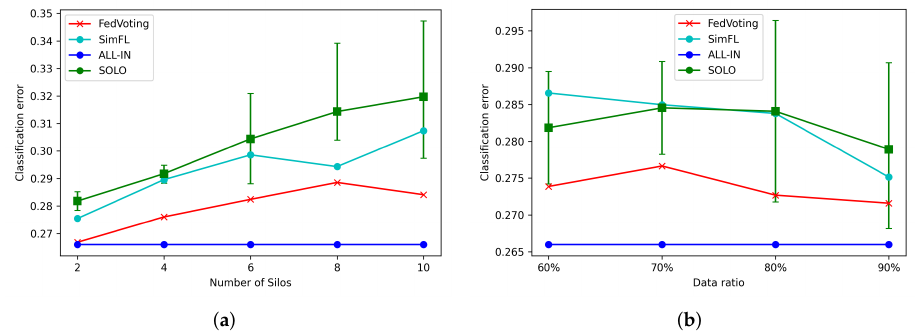
Figure 6. The prediction results of Comiket attendance in different conditions. ( a ) Classification errors of different numbers of silos (Data ratio = 0.5). ( b ) Classification errors of different ratios of the data volume (Silo number =